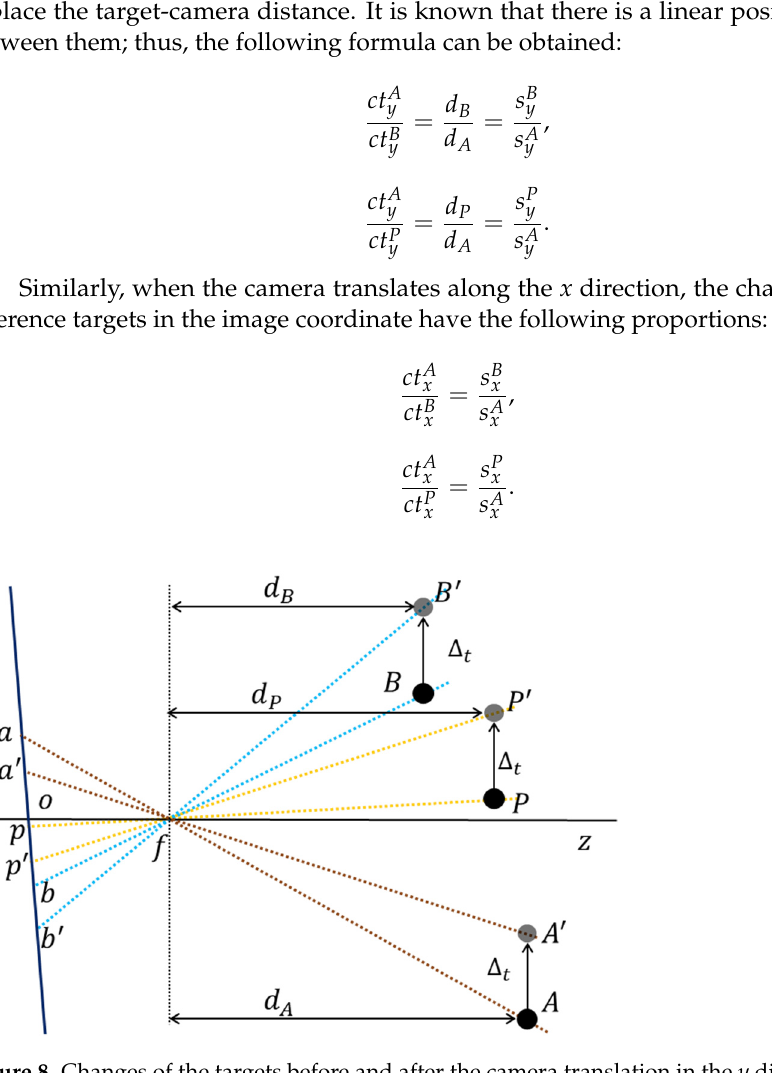
Figure 8. Changes of the targets before and after the camera translation in the 𝑦 direction.